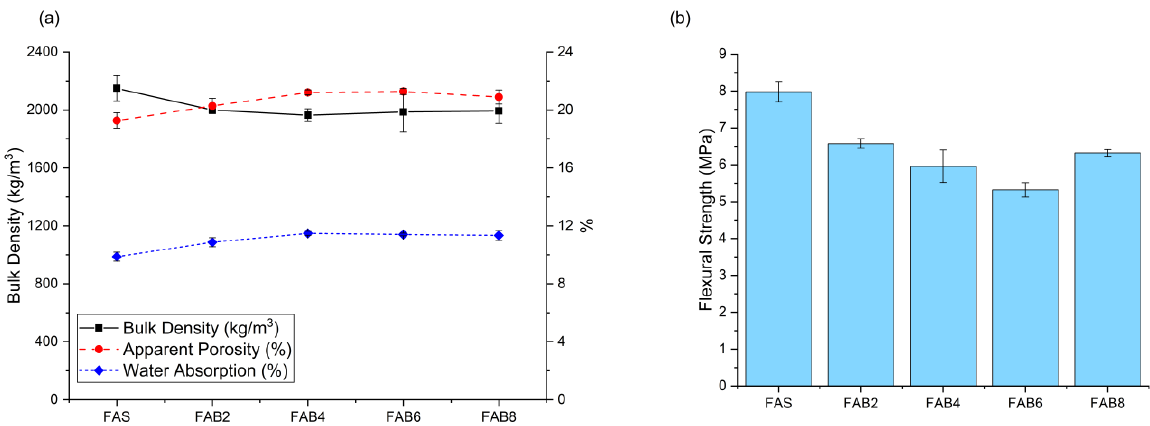
Figure 4. ( a ) Bulk density and porosity measurement and ( b ) flexural strength of unexposed thin FAS and FAB geopolymers.